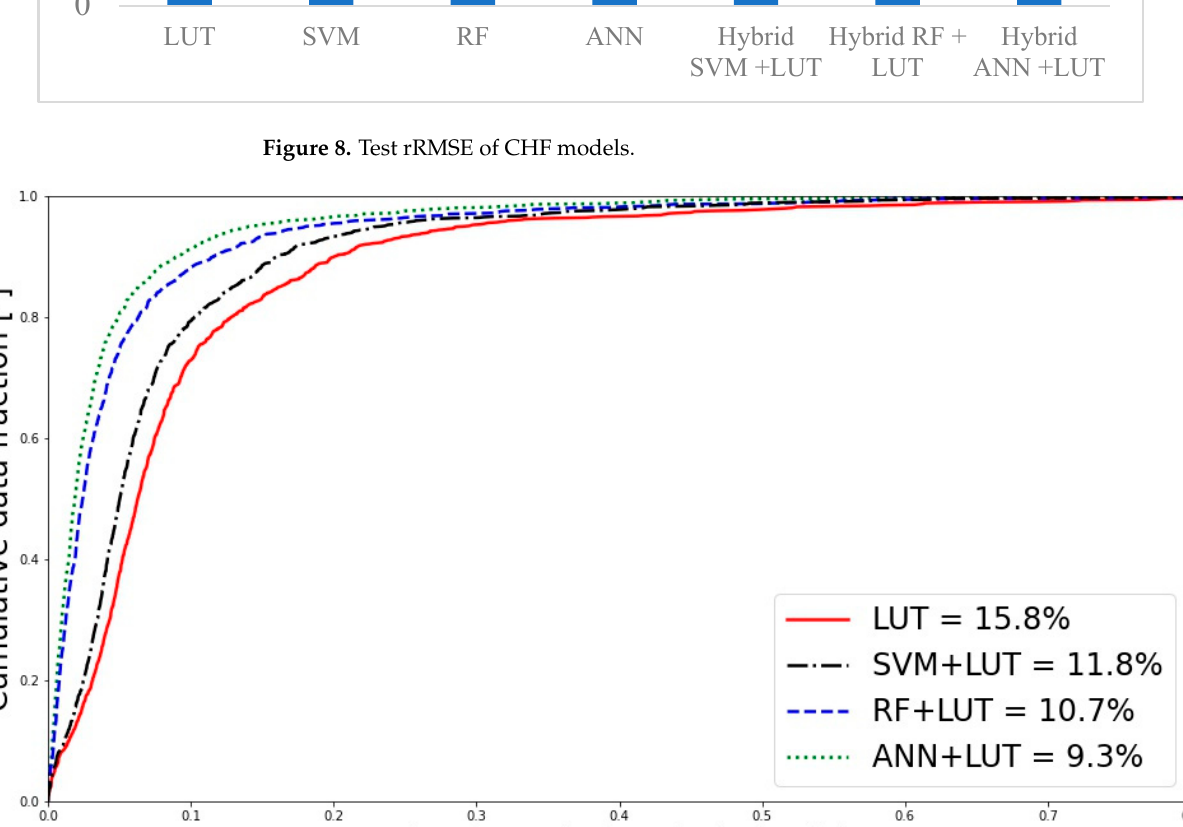
Figure 9. Absolute-relative deviation vs. data fraction of hybrid models .